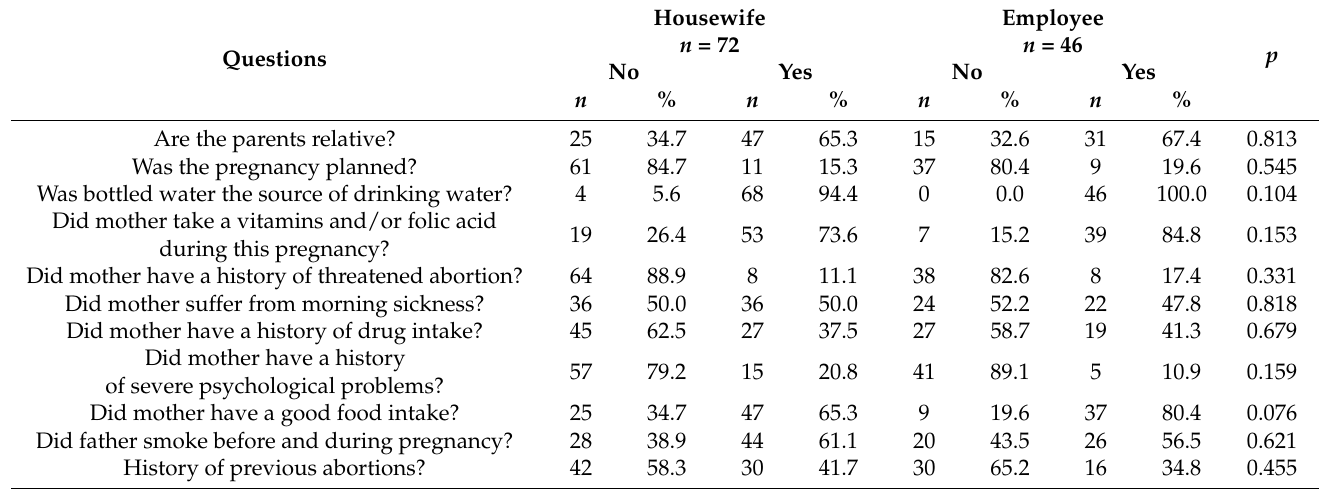
Table 3. Results addressing the risk factors for cleft lip and palate.